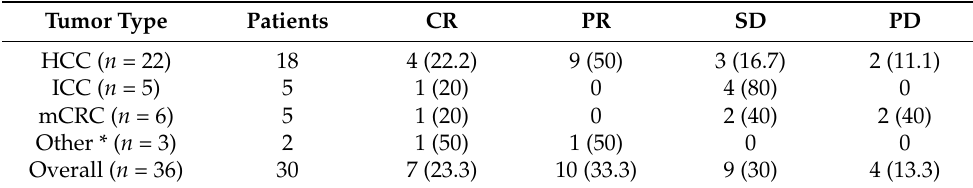
Table 2. Best radiological response according to tumor type in patients treated in 2020. Tumor